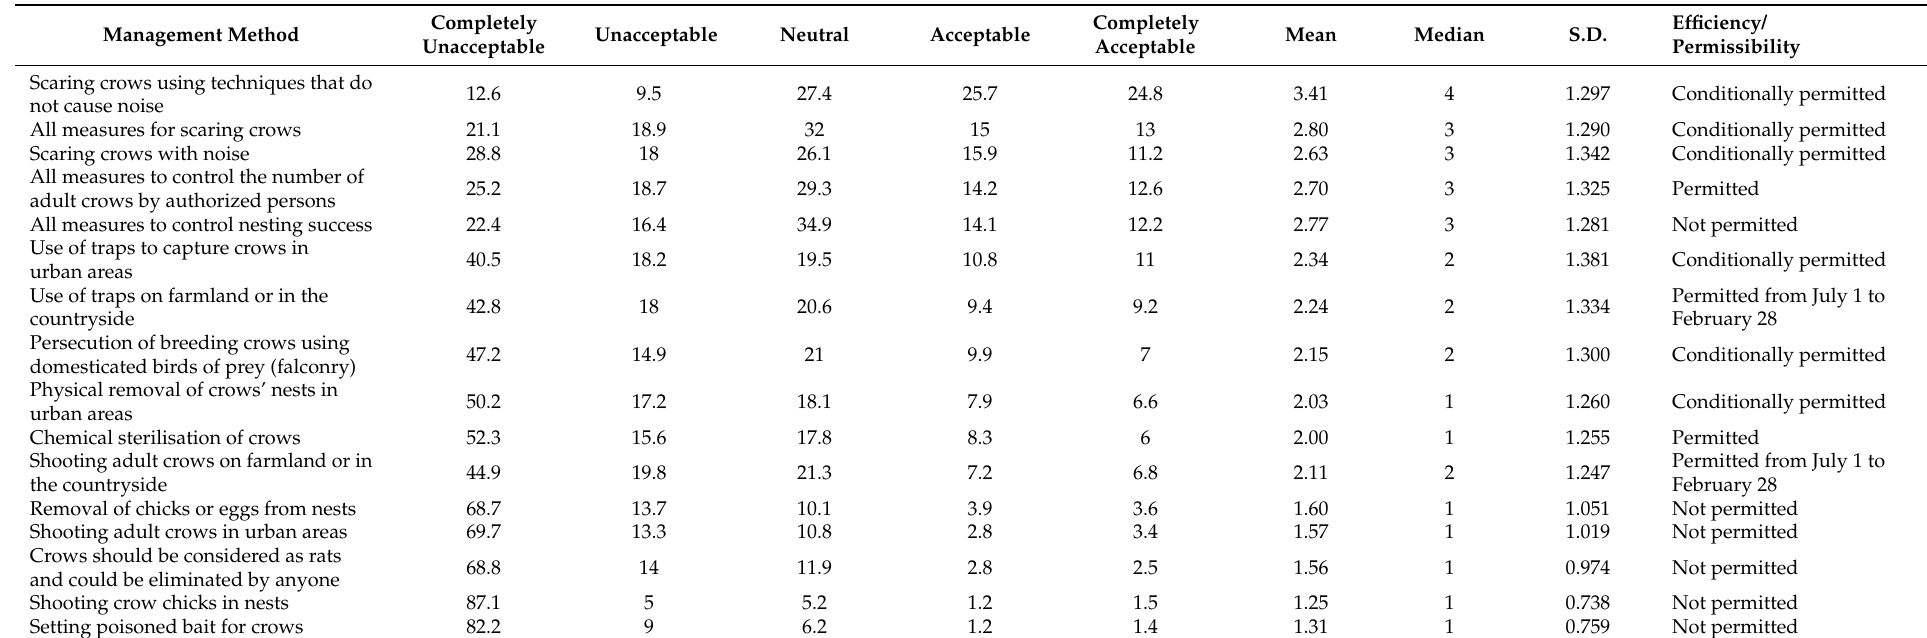
Table 4. Percentages, mean, median and S.D. of acceptability of population management methods (listed in decreasing order of the sum of “Acceptable” and “Completely acceptable”